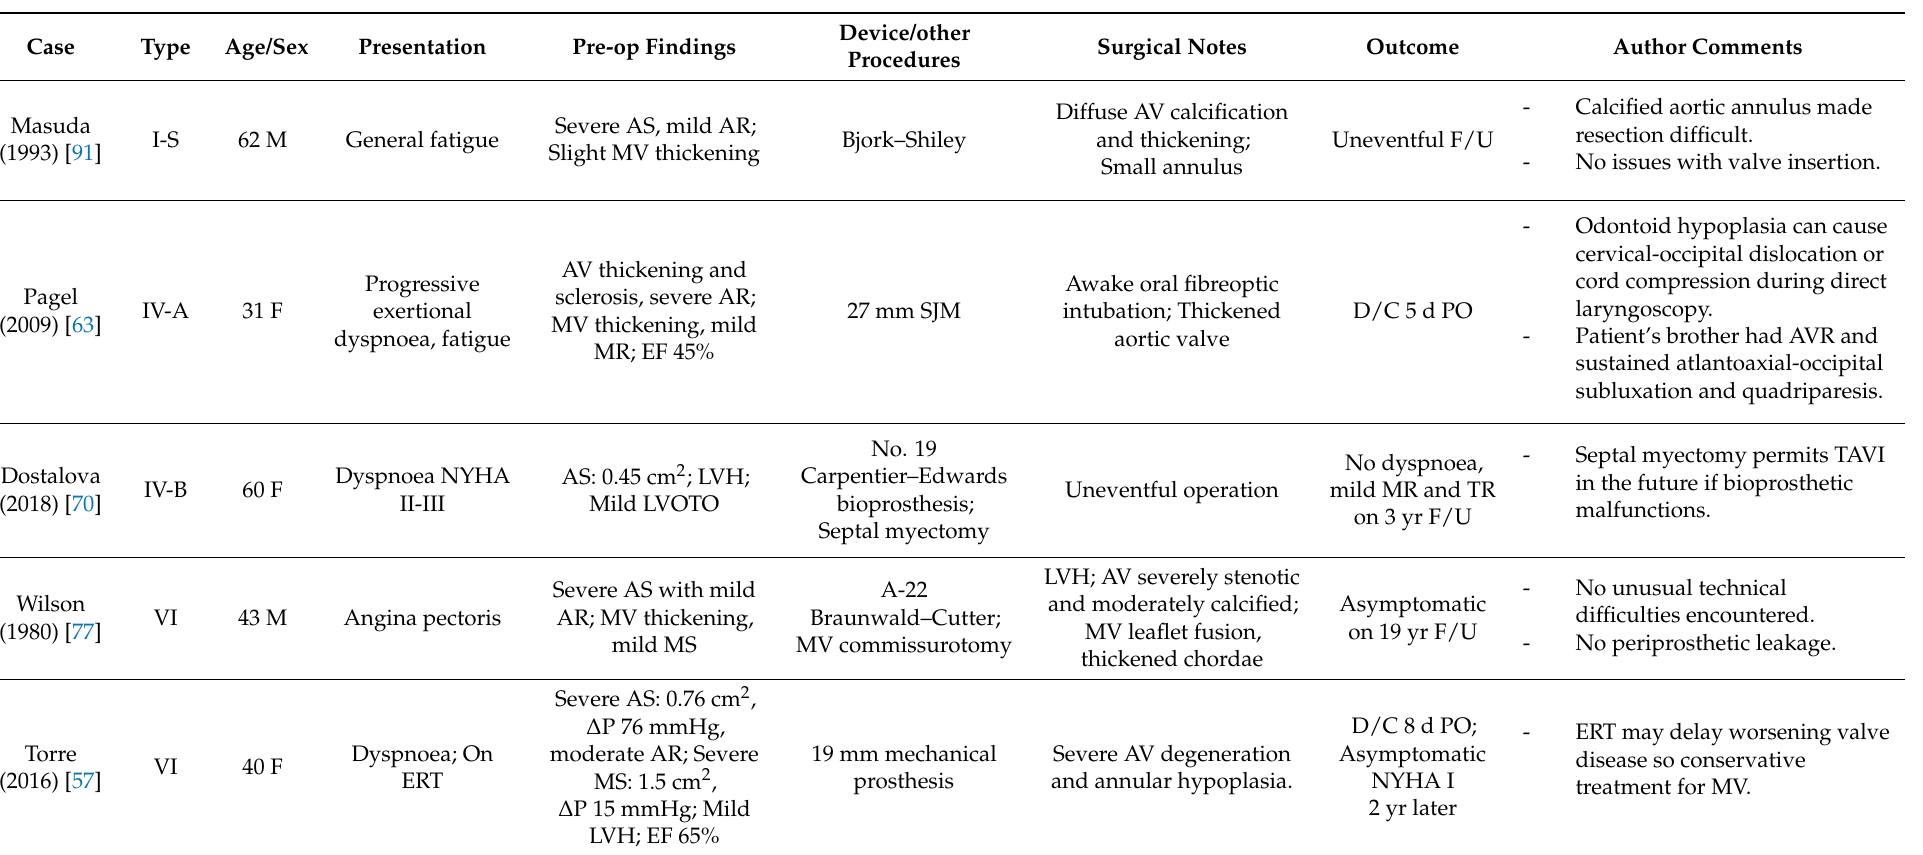
Table A1. Description of case reports of aortic valve replacement in MPS